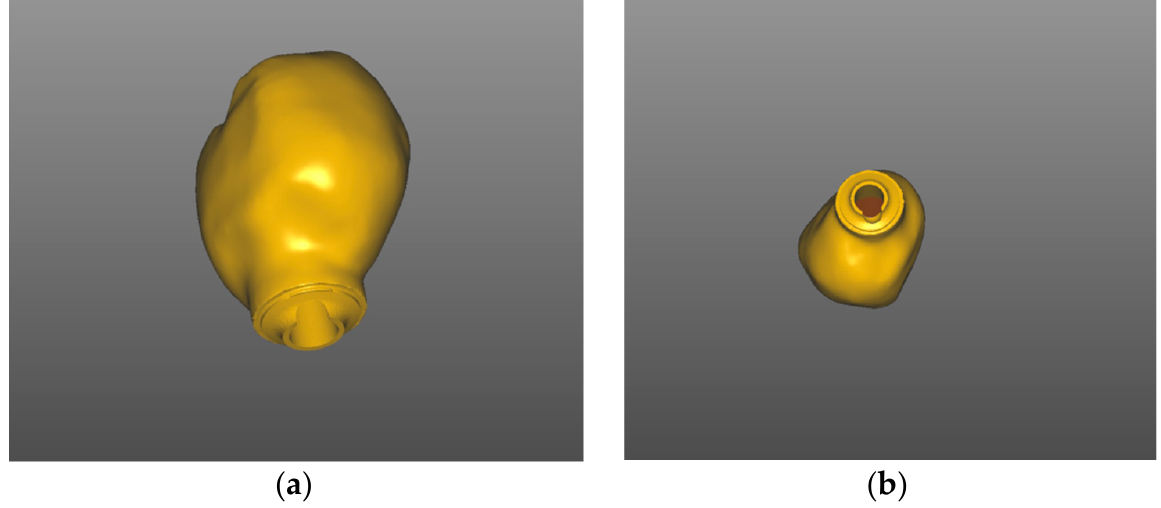
Figure 12. Chairside digital design for implant 14 exocad, SW 3.0 Galway: ( a ) bucco-distal view; ( b ) bucco-inferior view.